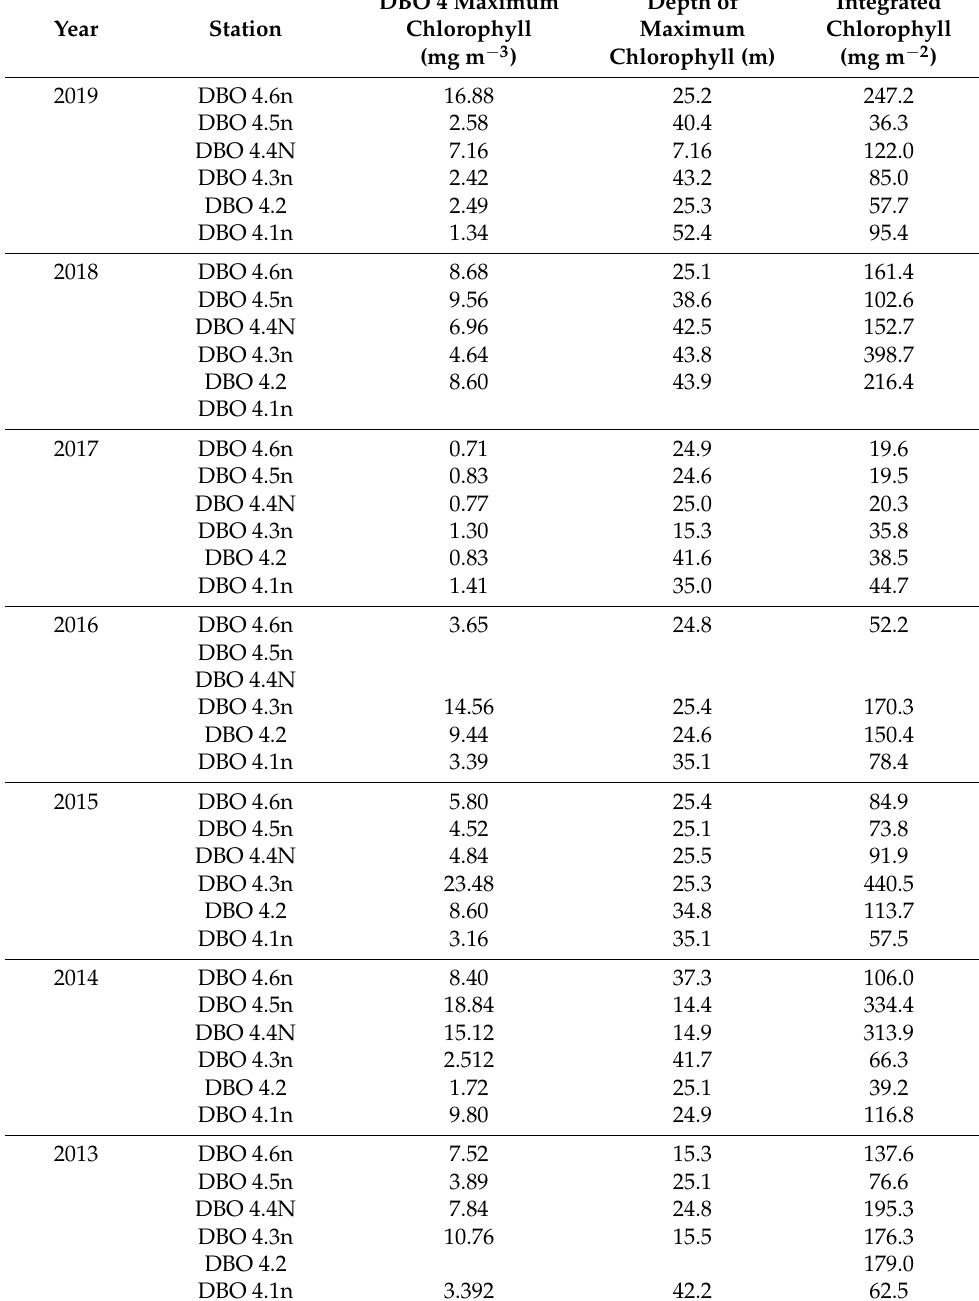
Table 4. DBO 4 Stations, northwest Chukchi shelf, 7-year time series for